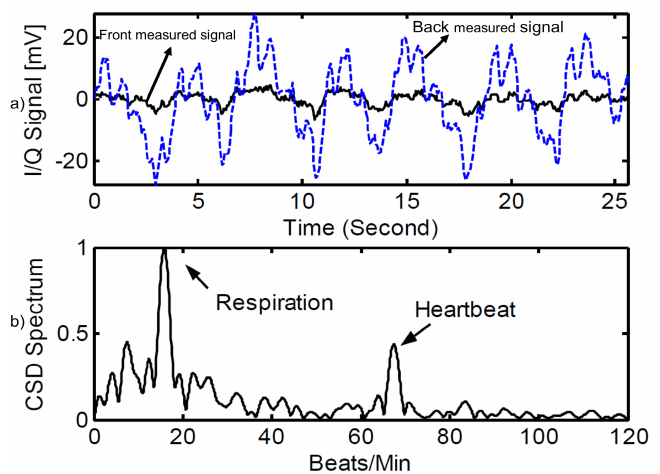
Figure 1. Received signal in the time domain ( a ) and in the frequency domain ( b ) at a distance of 0.5 m